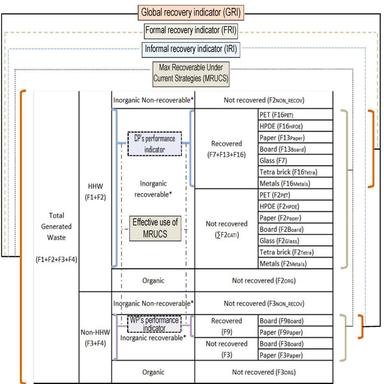
System mass balance table for the current recovery strategies and all general indicators.